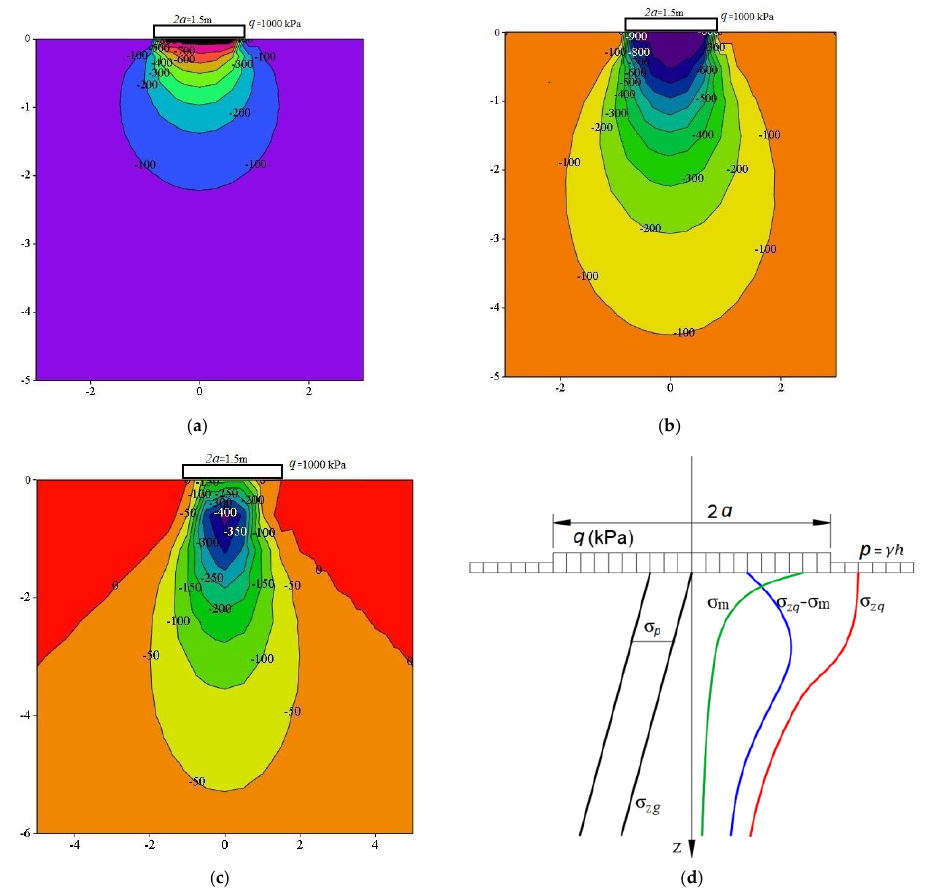
Figure 6. Color shadings of σ m ( a ), σ z ( b ), and σ z − σ m ( c ) (at a = 0.75 m; b = 1.5 m; q = 1000 kPa) and the calculation scheme for calculating shear and volumetric strain based on Hencky’s system of physical equations ( d